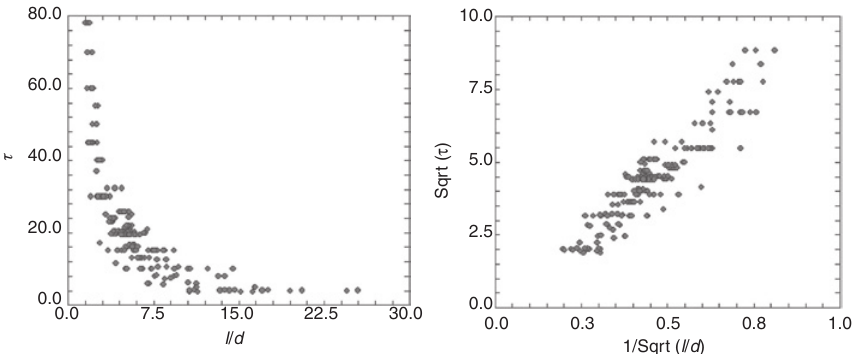
Figure 16: Subsequent conversion of the original version and scatter plots of variables.